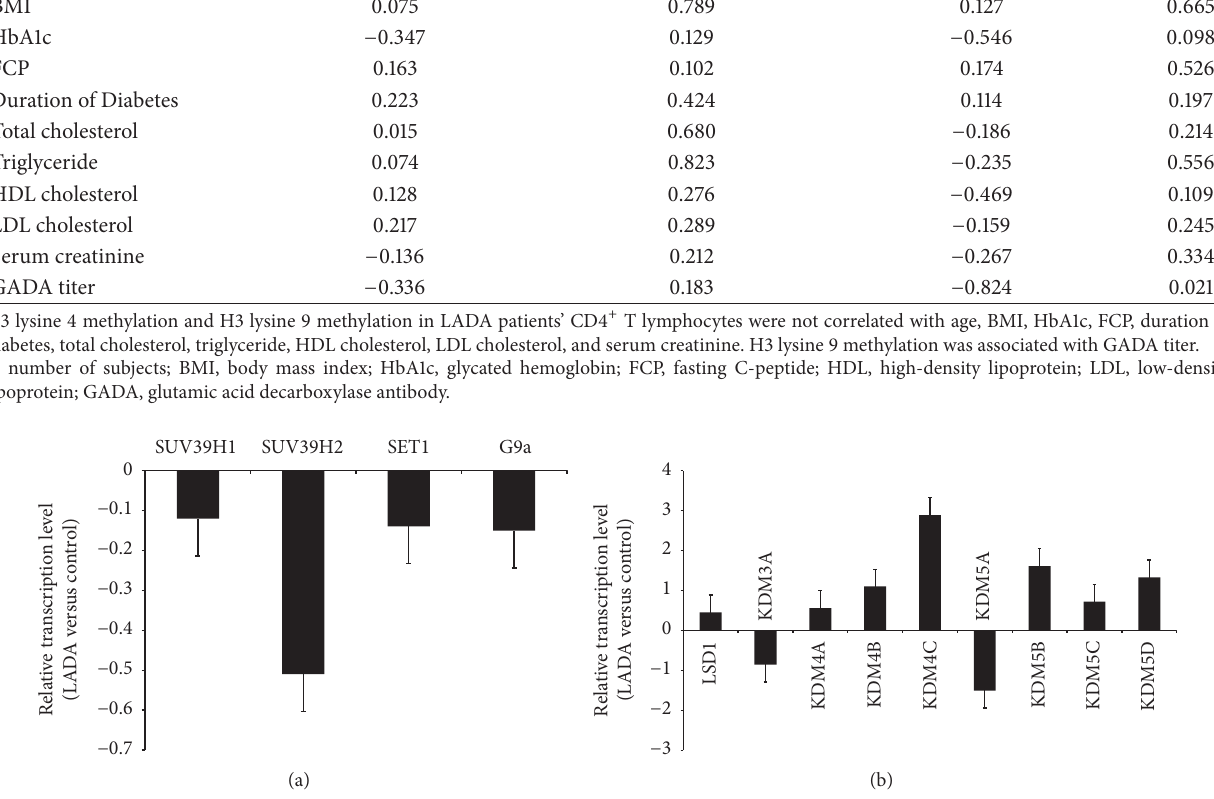
Figure 3: The mRNA level of histone methyltransferase and demethylase in CD4 + T lymphocytes from LADA patients. Data are normalized against beta-actin. The Δ Ct values were from 0.5 to 3.9. (a) Relative mRNA levels of histone methyltransferases (SET1, G9a, SUV39H1, and SUV39H2) in CD4 + T lymphocytes from LADA patients ( 𝑛 = 26 ) and healthy controls ( 𝑛 = 26 ), as measured by real-time PCR. The absolute of fold change > 2 was considered significant, LADA patients versus healthy controls; data are normalized against beta-actin. (b) Relative mRNA levels of histone demethylases (LSD1, KDM3A, KDM4A, KDM4B, KDM4C, KDM5A, KDM5B, KDM5C, and KDM5D) in CD4 + T lymphocytes from LADA patients ( 𝑛 = 26 ) and healthy controls ( 𝑛 = 26 ), the absolute of fold change > 2 was considered significant, LADA patients versus healthy controls; data are normalized against